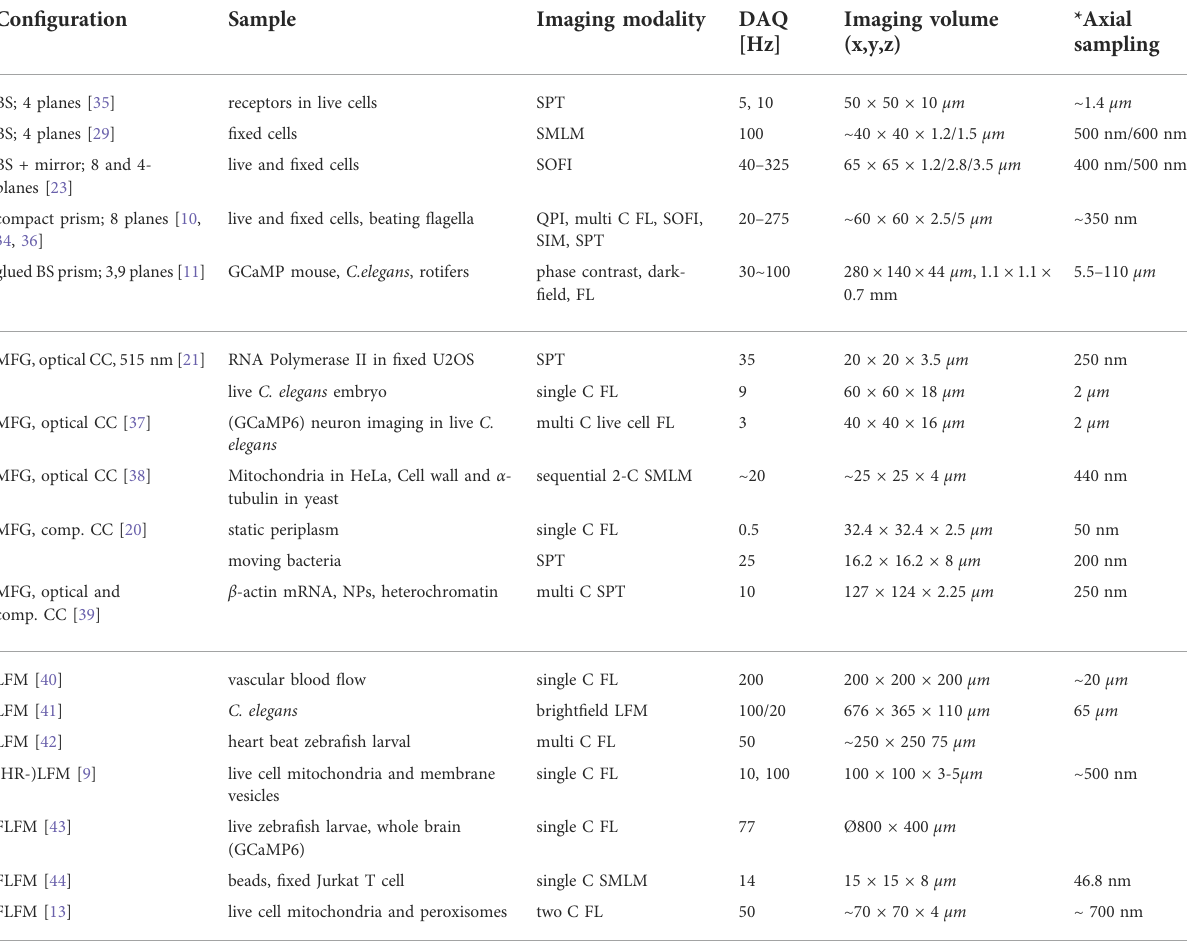
TABLE 1 Representative selection of volumetric imaging con fi gurations. BS: beamsplitter, C: color, DAQ: data acquisition, FL: fl uorescence, NP: nuclear pore, SPT: single particle tracking, SMLM: single molecule localization microscopy, SOFI: super-resolution optical fl uctuation imaging,